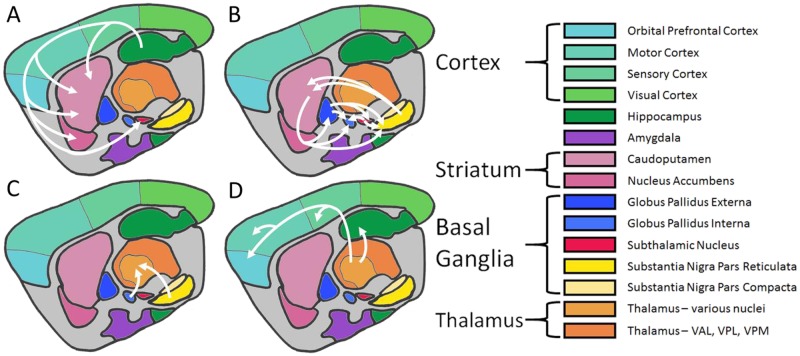
Cortex-basal ganglia-thalamus-cortex circuit in mice.Sagittal sketch of representative structures involved in the circuit. A) Cortex neurons transmit glutamate to the striatum and subthalamic nucleus. Striatum interneurons transmit acetylcholine. B) The striatum transmits GABA to the globus pallidus externa, globus pallidus interna, and substantia nigra reticulata. The globus pallidus externa transmits GABA to the subthalamic nucleus, globus pallidus interna, and substantia nigra reticulata. The subthalamic nucleus transmits glutamate to the globus pallidus interna and substantia nigra reticulata. The substantia nigra pars compacta transmits dopamine to the striatum where some terminals synapse on upregulating receptors and some on downregulating receptors. C) The globus pallidus interna and substantia nigra reticulata transmit GABA to the thalamus. D) The thalamus transmits glutamate to the cortex. While these structures and chemicals do not exist in isolation, dysregulation of any of these molecules may have reverberating effects on the entire circuit. [Figure created with information from Conn et al. (2005) [19], Arnsten and Rubia (2012) [51], and the Allen Mouse Brain Atlas [52].]